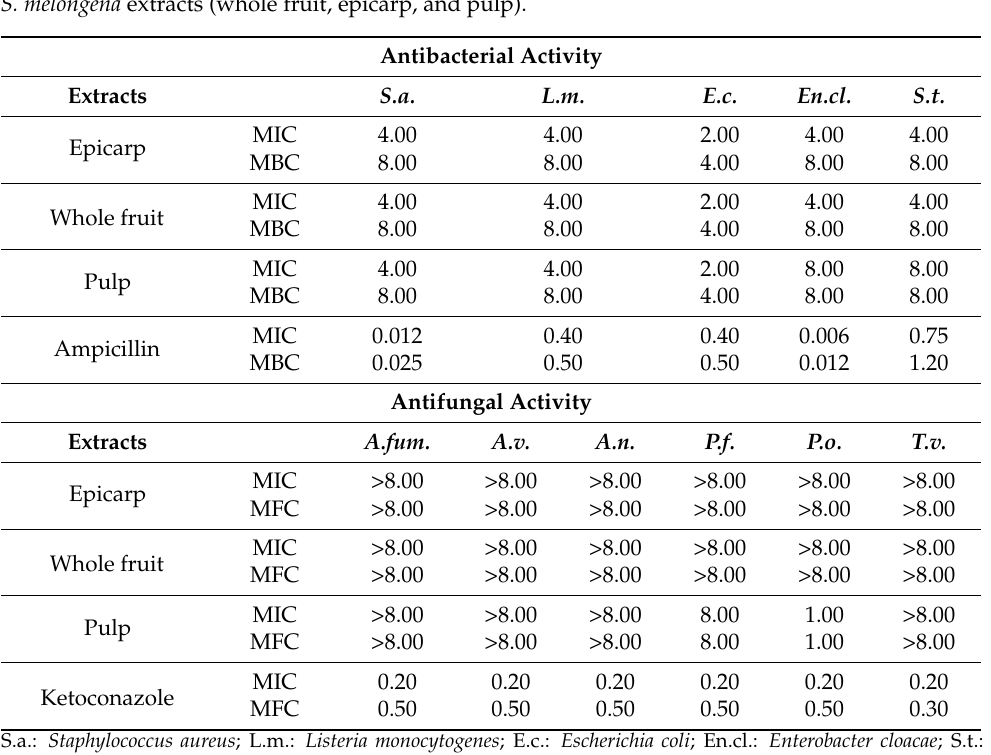
Table 7. Antibacterial (MIC and MBC mg/mL) and antifungal (MIC and MFC mg/mL) activity of S. melongena extracts (whole fruit, epicarp, and